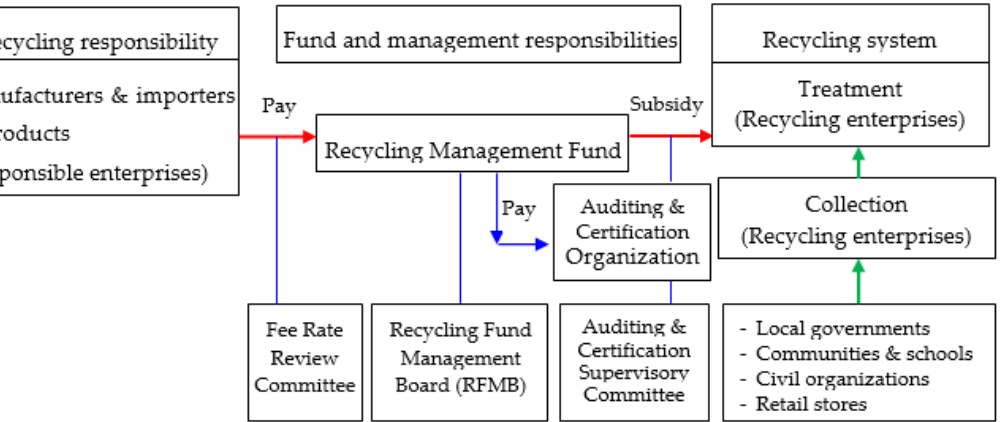
Figure 1. Simplified operation mode of the 4-in-1 Recycling Program in